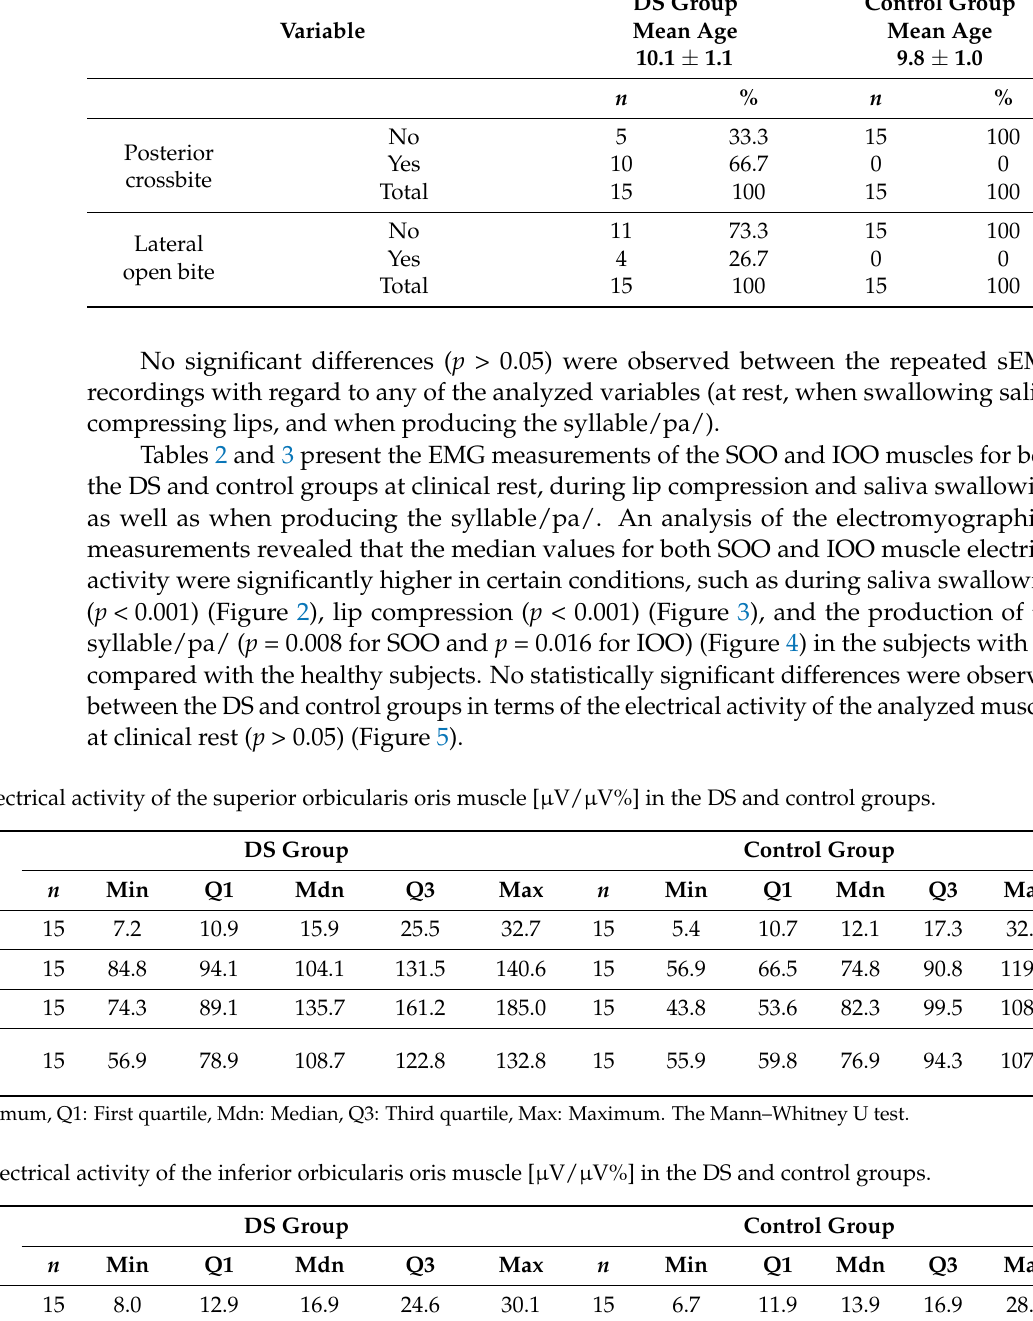
Table 3. Electrical activity of the inferior orbicularis oris muscle [ µ V/ µ V%] in the DS and control groups. DS Group Control Activity